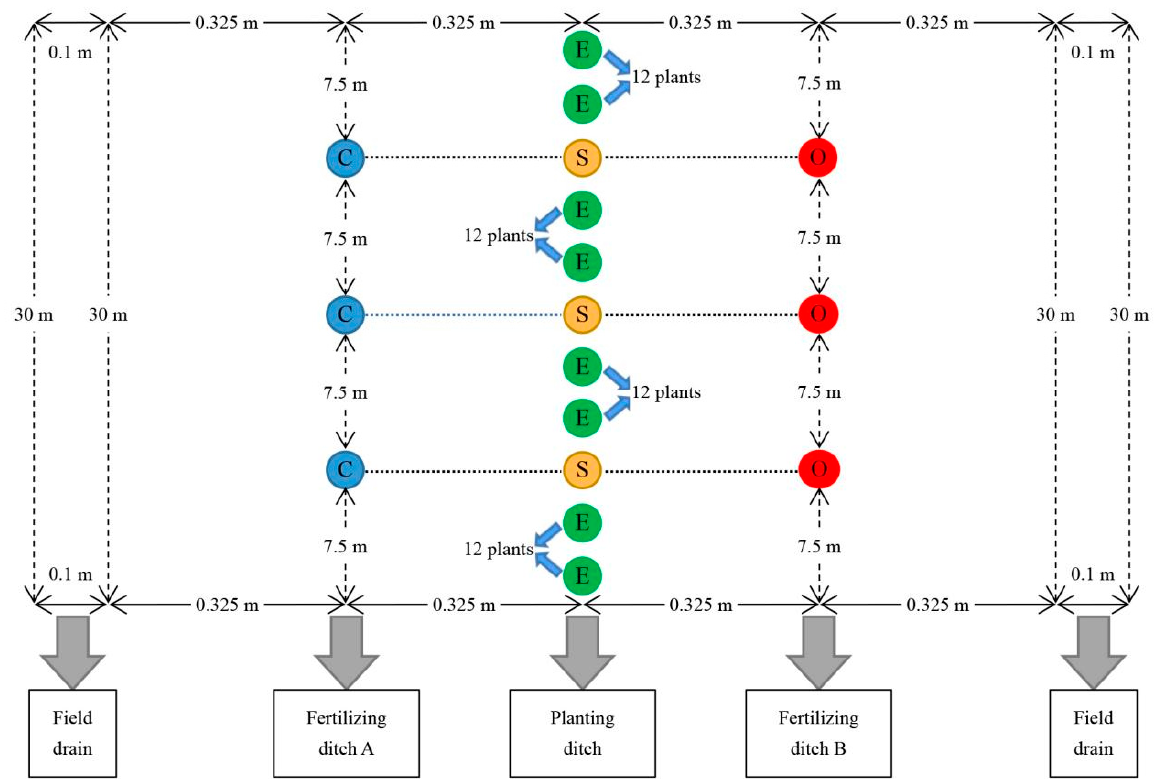
Figure 1. Ichnograph of three sets of locations on each experimental plot (1.3 m in width × 30 m in length). The blue circles with letter C represent the top-covered tubes, the orange ones with letter S indicate the starting tubes, the red ones with letter O denote the top-open tubes, and the green ones with letter E are the eggplant seedlings. The width (solid lines with double arrows) and length (dashed lines with double arrows) scales for each experimental plot are 1:10 and 1:375, respec- tively. Table 3. Treatments with different rates (dry basis) of chemical fertilizer and palm silk biochar (PSB) applied. Rate of Chemical Fertilizer and PSB Applied